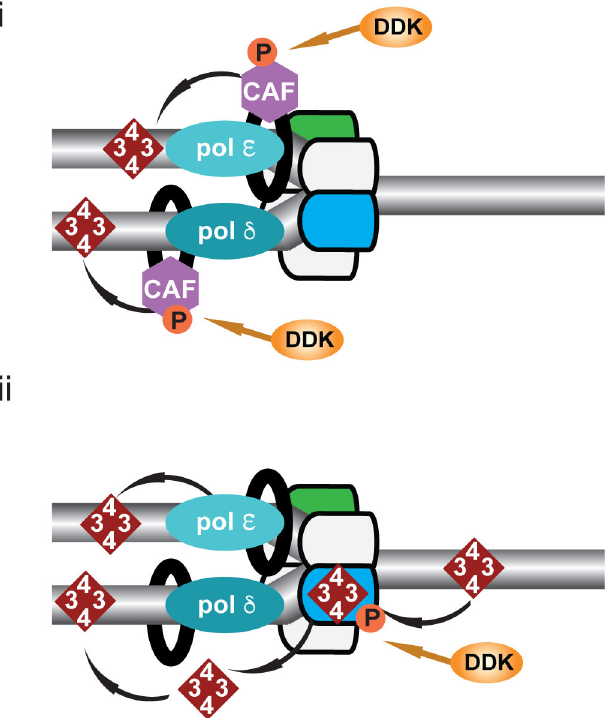
Figure 4. DDK and post ‐ replicative chromatin re ‐ formation. Cartoon illustrating DDK ‐ mediated chromatin re ‐ formation following DNA replication. ( i ) Chromatin assembly factor 1 (CAF ‐ 1), a DDK substrate in both budding yeast and higher eukaryotes, binds PCNA (black ring) and deposits H3:H4 tetramers (red diamond) behind the replication fork on newly synthesized DNA. ( ii ) Parental H3:H4 tetramers are distributed to the lagging strand by MCM2 (blue), a DDK substrate and to the leading strand by DNA polymerase ε .